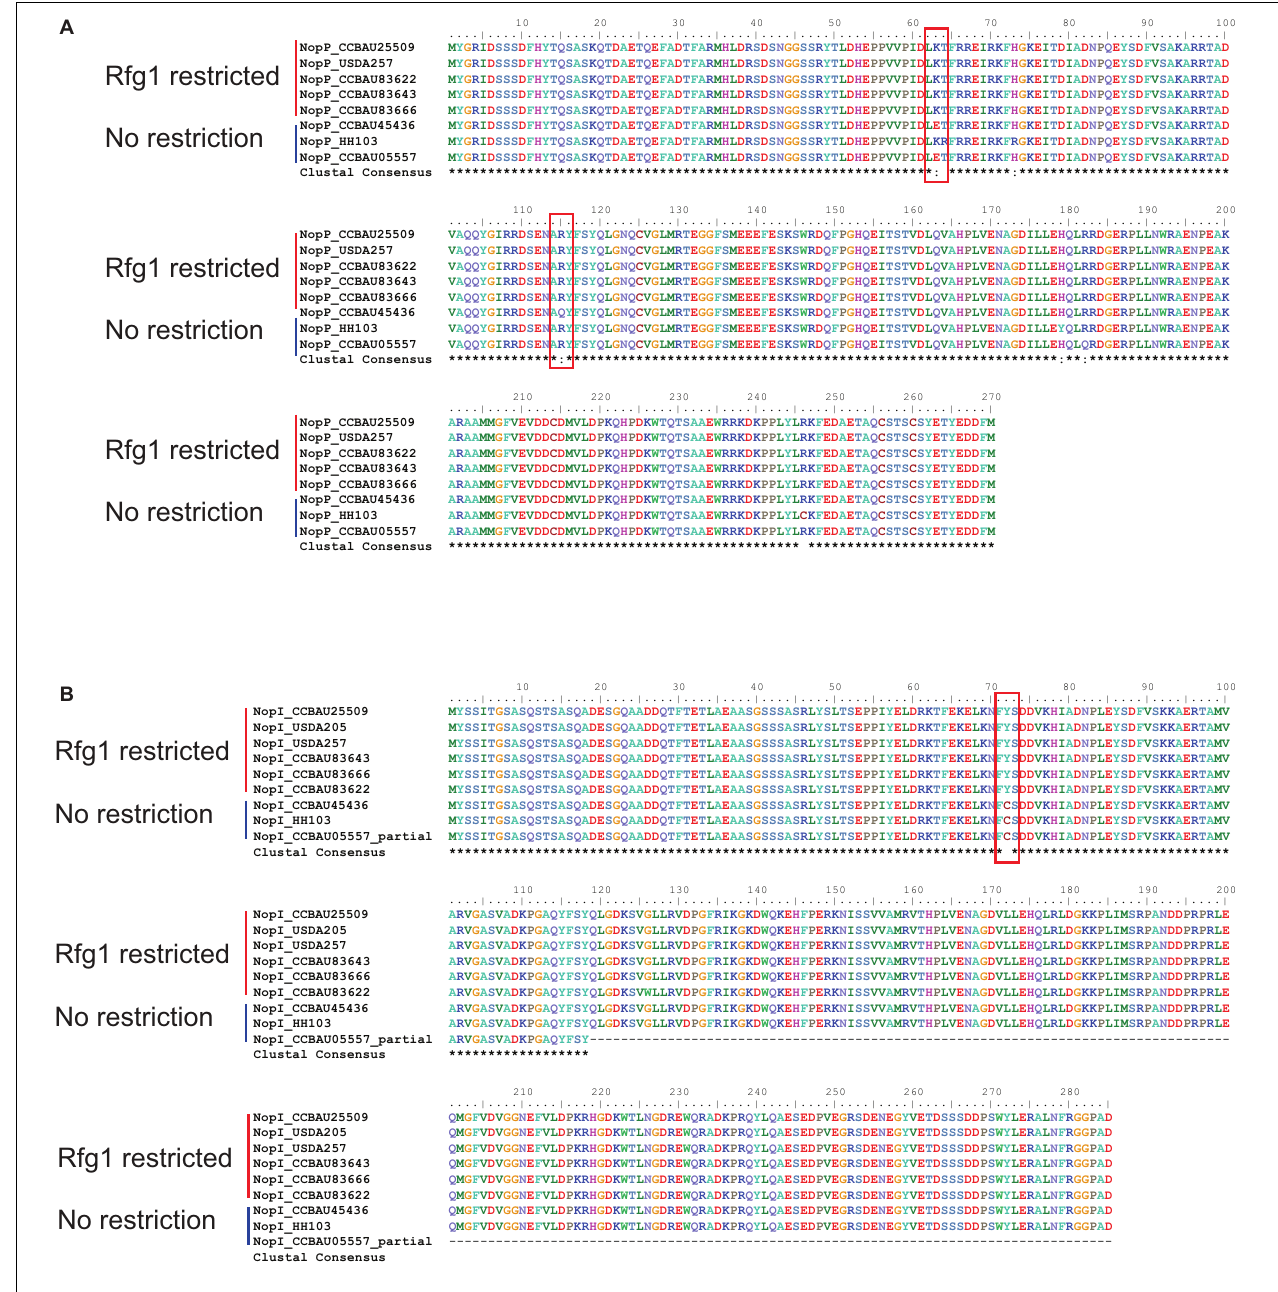
FIGURE 6 | NopI and NopP protein sequence alignments between Rfg1 -compatible and incompatible S. fredii strains. Shown host compatibility is based on observed phenotypes in previous publications (Yang et al., 2010; Jiménez-Guerrero et al., 2017; Jiao et al., 2018; Temprano-Vera et al., 2018). (A) NopP alignment showing K63E and R115Q amino acid substitutions. (B) NopI alignment showing a Y72C amino acid substitution.